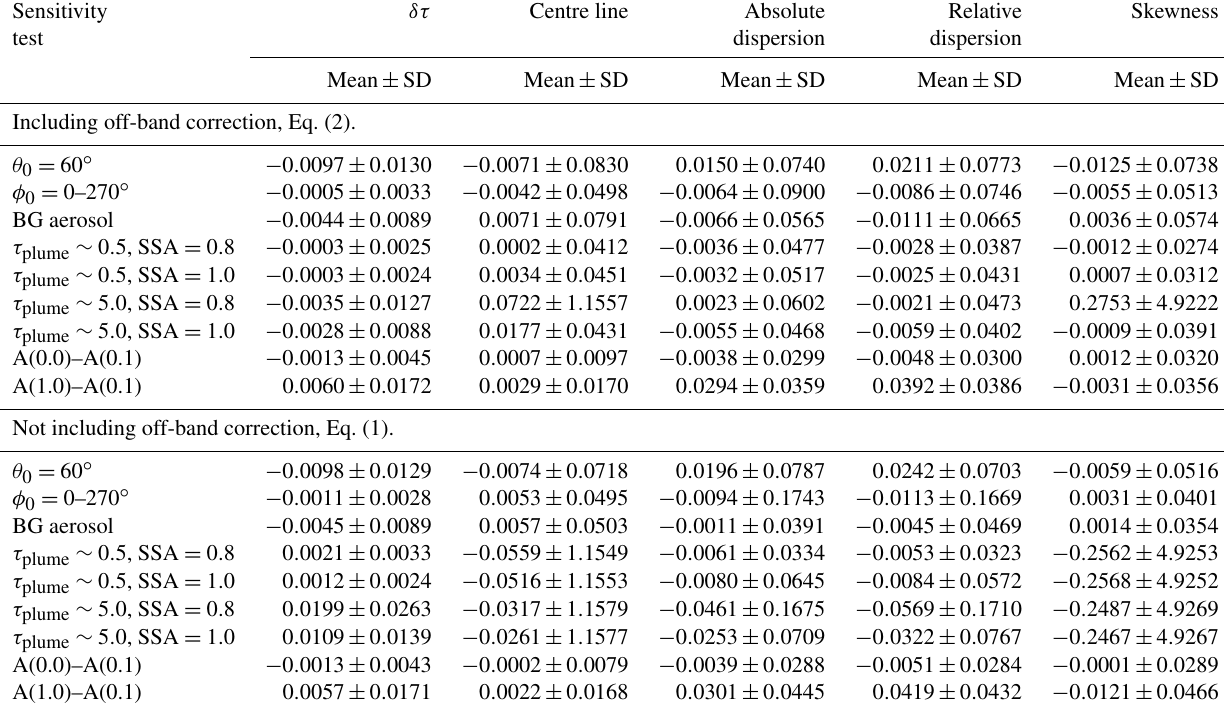
Table 3. Summary of differences in statistics between the baseline case shown in Fig. 4 and the sensitivity tests (first column). The second column reports the mean and standard deviation (SD) of the difference in absorbance ( δτ ). For the centre line, absolute dispersion, and relative dispersion, the mean and standard deviation (SD) are given in units of metres. For the azimuth dependence sensitivity, tests were made for a range of angles; the numbers in the table are the extreme values for all these tests. Sensitivity δτ Centre line Absolute Relative